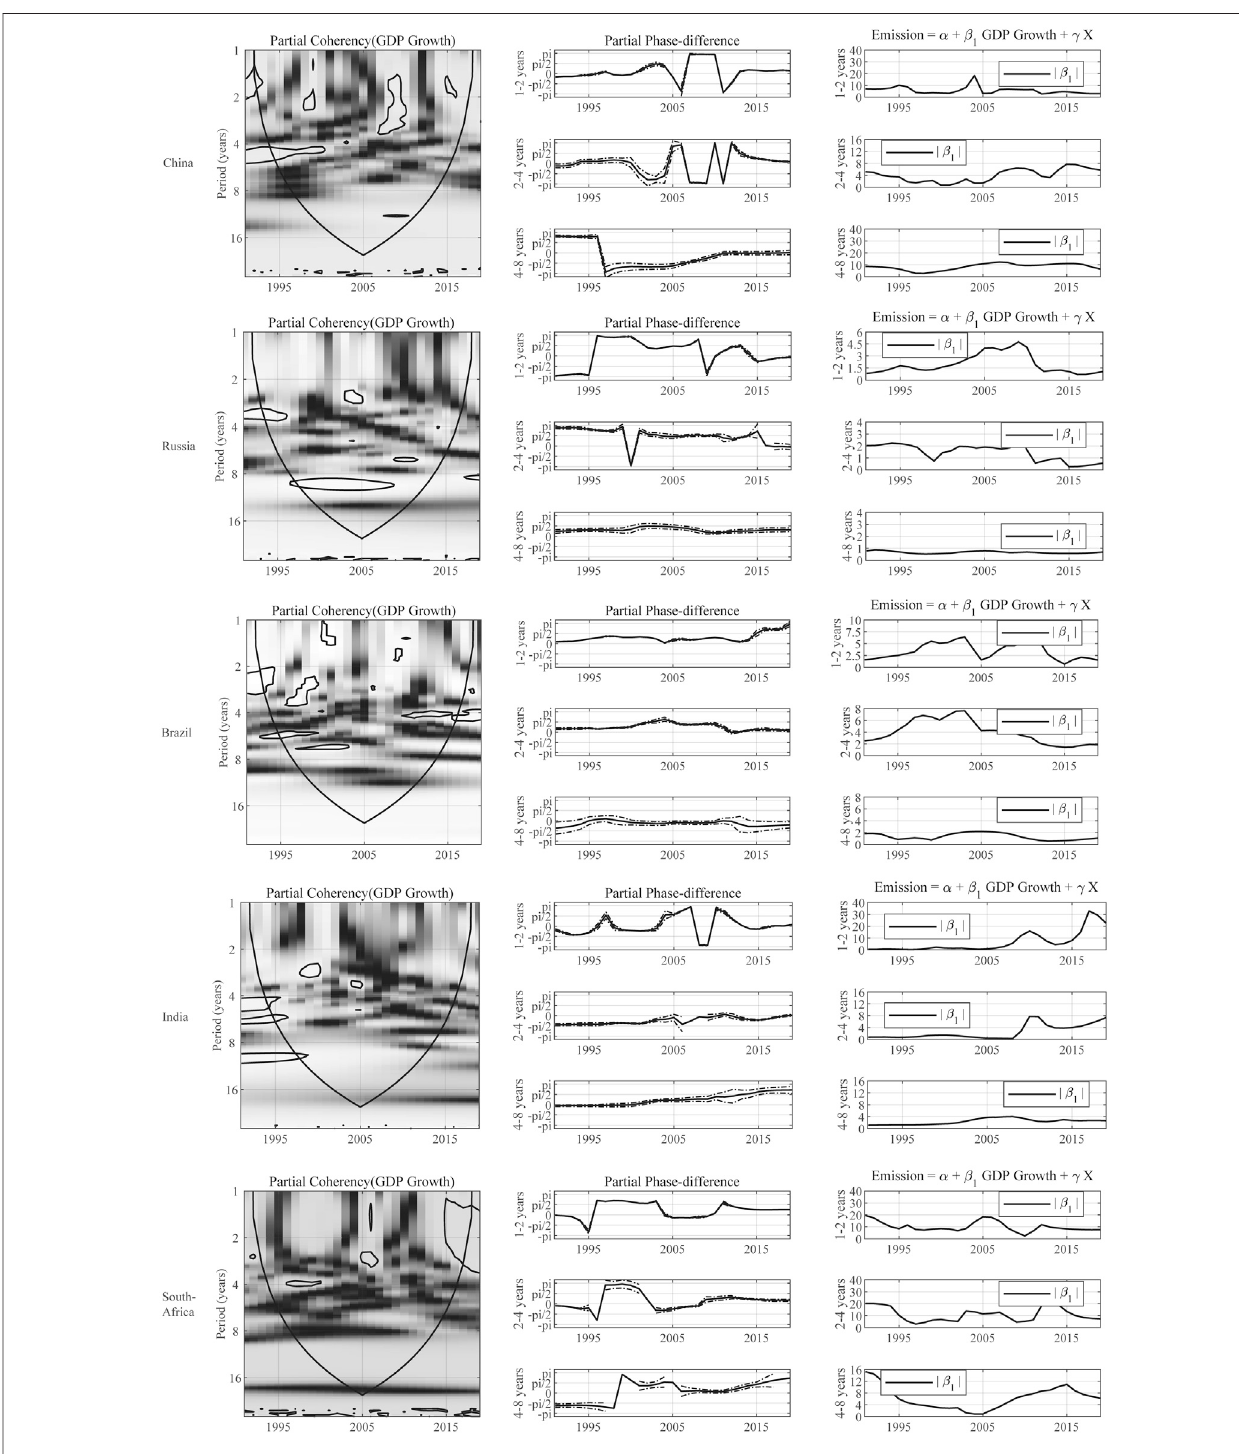
FIGURE 10 | Multivariate wavelet analysis results controlled for additional factors. Note: The expression “ Partial Coherency (Z) ” denotes the partial coherency between variable Z and carbon emission, controlled for the in fl uence from other factors. The areas below the symmetric black convex curve that appears in the fi gure of coherencyarecalledthe “ ConeofIn fl uence(COI), ” inwhichtheedgeeffectsareprofound.InsidetheCOI,theresultstendtobeunreliable.Thecontoursinthecoherency diagrams indicate 5% signi fi cance level, bootstrapped for 10,000 replications. And, the brighter colors correspond to higher signi fi cance level, and darker colors correspond to lower signi fi cance level. The dotted lines accompanying the partial phase-difference indicate the 95% con fi dence intervals.